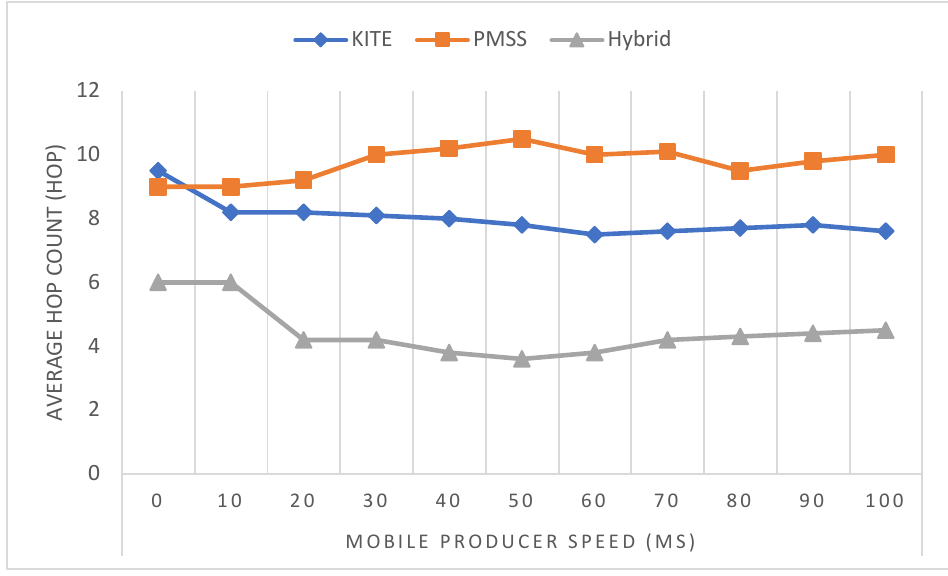
Figure 11. Handover latency (hop count) versus speed.